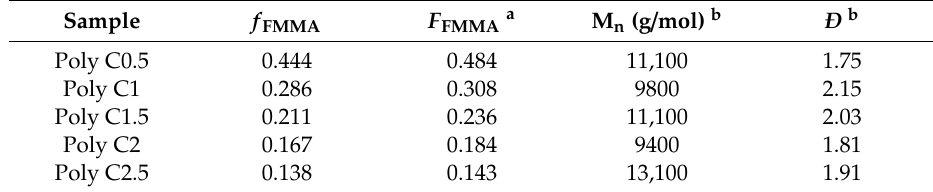
Figure 3. SEM images and corresponding elemental mapping results for C, O, and Fe for electrospun/sprayed Poly C0.5 and Poly C2.5 samples, and obtained atomic concentrations. Table 1. Characteristics of synthesized poly(FMMA- r- MA)